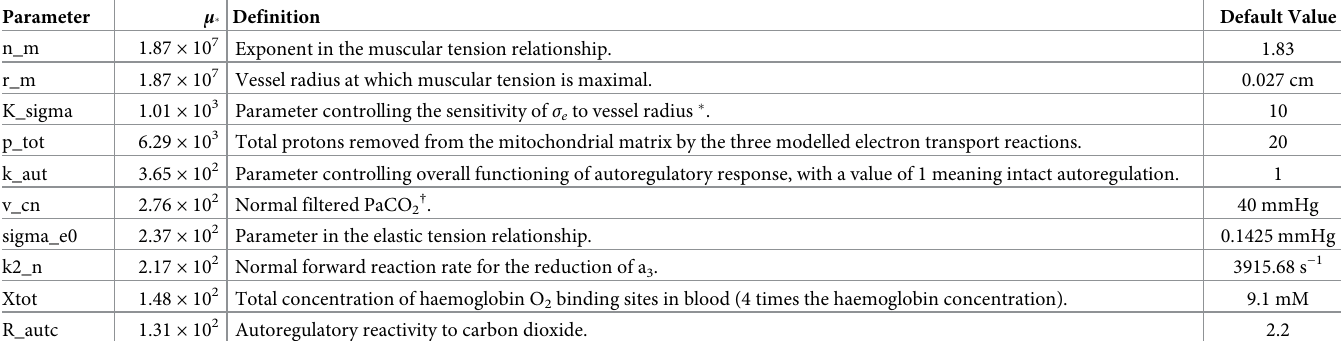
Table 3. Sensitivity analysis results for experimental data, including each selected parameter’s definition and default value. � See [6] and [3] for a full explanation of this parameter and the stimulus μ . † This is the arterial PaCO 2 input put through a first order filter to simulate varying time response and is typically the same as arterial PaCO 2 . For more information see